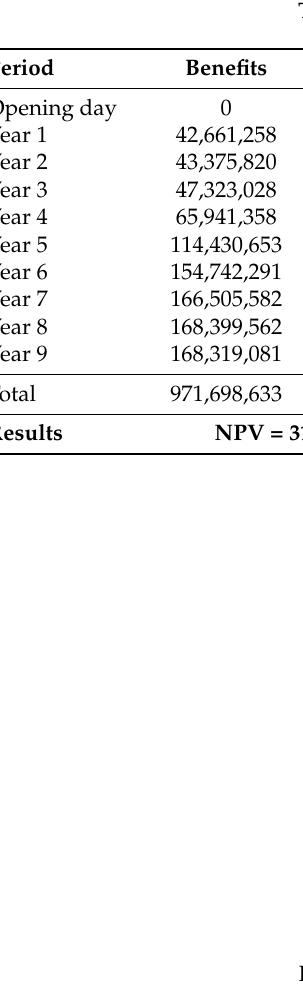
Figure 6. Plot of the project net cash flow over the project’s life.